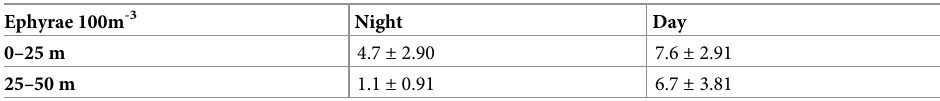
Table 1. Ephyrae abundance (mean ± standard error) by day/night and depth